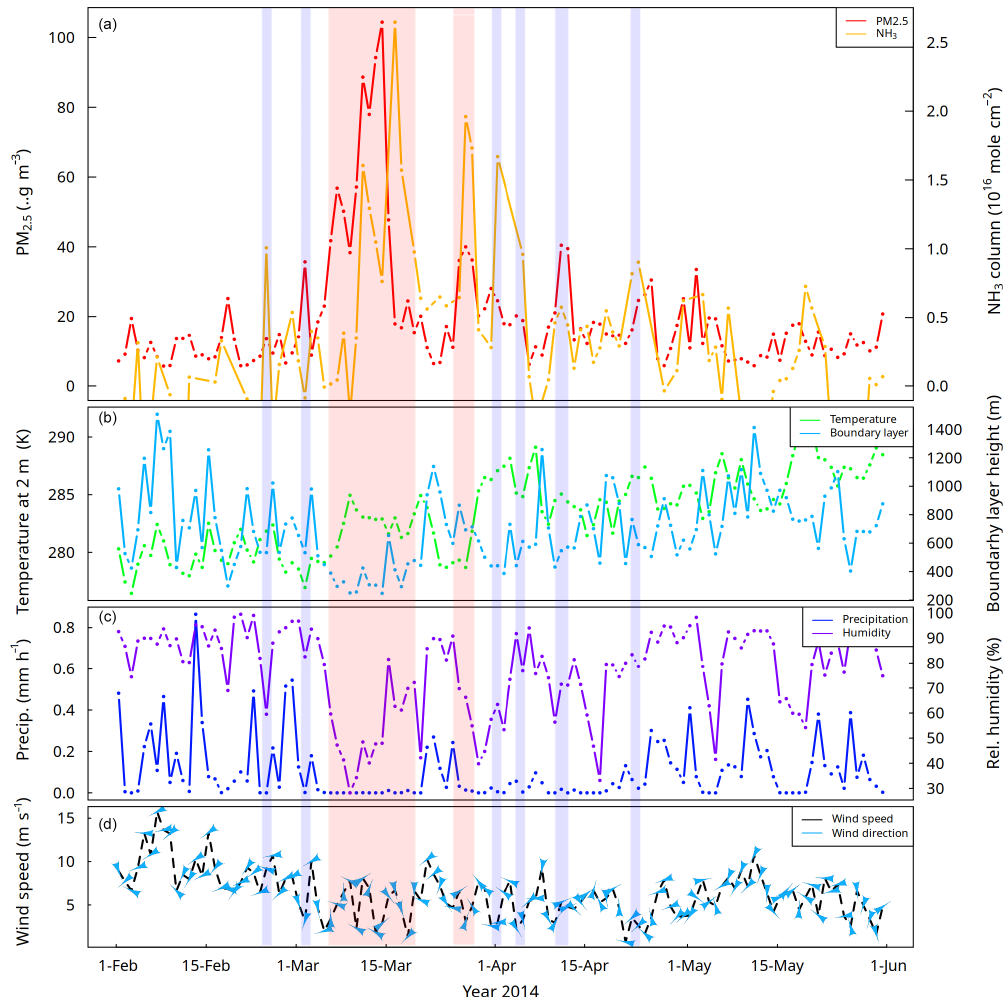
Figure 12. Average concentrations of NH 3 total columns derived from IASI observations (in moleculescm − 2 ; orange; a ) and PM 2 . 5 derived from the Airparif network selected within 2h from the IASI overpass (in µgm − 3 ; red; a ) for 2014 as an example. Periods of simultaneous (independent) enhancements of NH 3 and PM concentrations are represented with red (blue) areas, i.e. in case A (case B). Temperature at 2m (in kelvin; green; b ), boundary layer height (in metres; blue; b ), precipitation (in metres; dark blue; c ), relative humidity (in percent; purple; c ), and (d) wind speed and direction derived from the ECMWF ERA-5